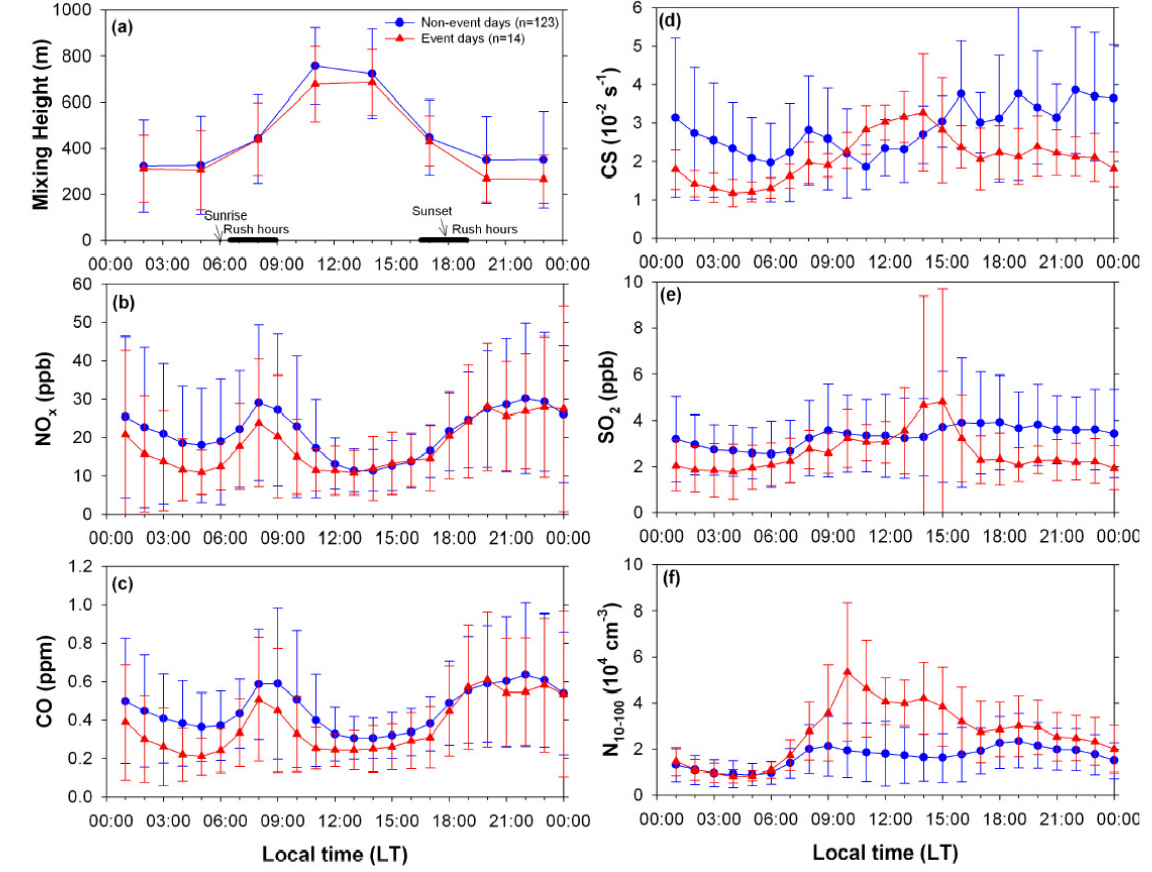
Fig. A2. Diurnal variations of the average (a) mixing height, (b) NO x , (c) CO, (d) condensation sink (CS), (e) SO 2 and (f) 10–100nm particle number ( N 10 − 100 ) concentrations on non-event and event